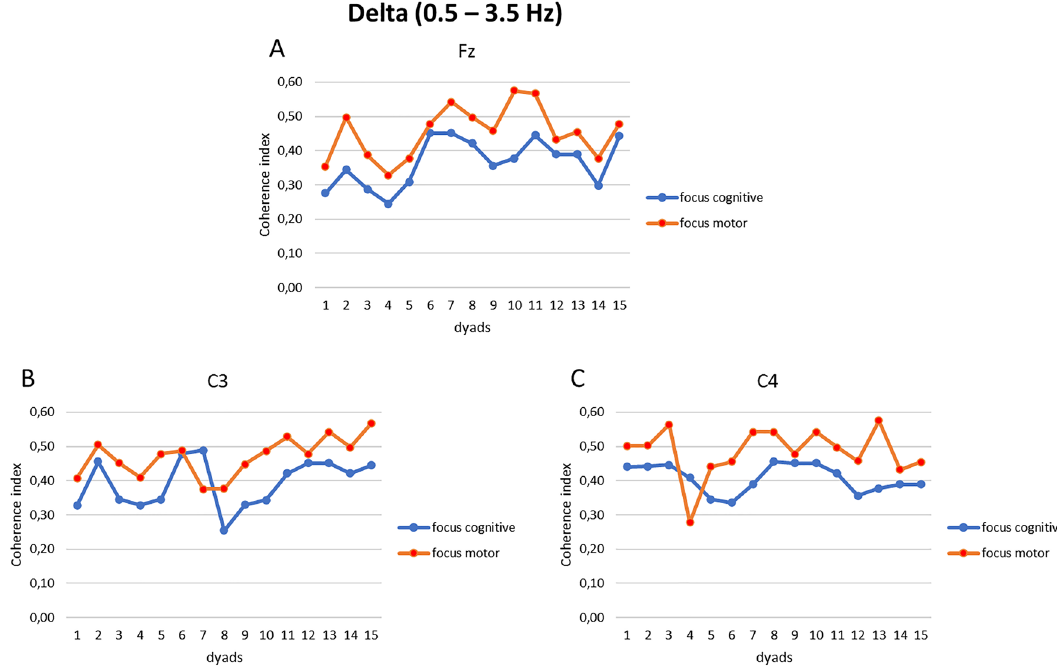
Figure 3. ( A – C ) EEG delta band coherence indices. Trend of the coherence indices modulation as a function of the synchronization tasks for the electrodes Fz ( A ), C3 ( B ), and C4 ( C ) in each dyad.